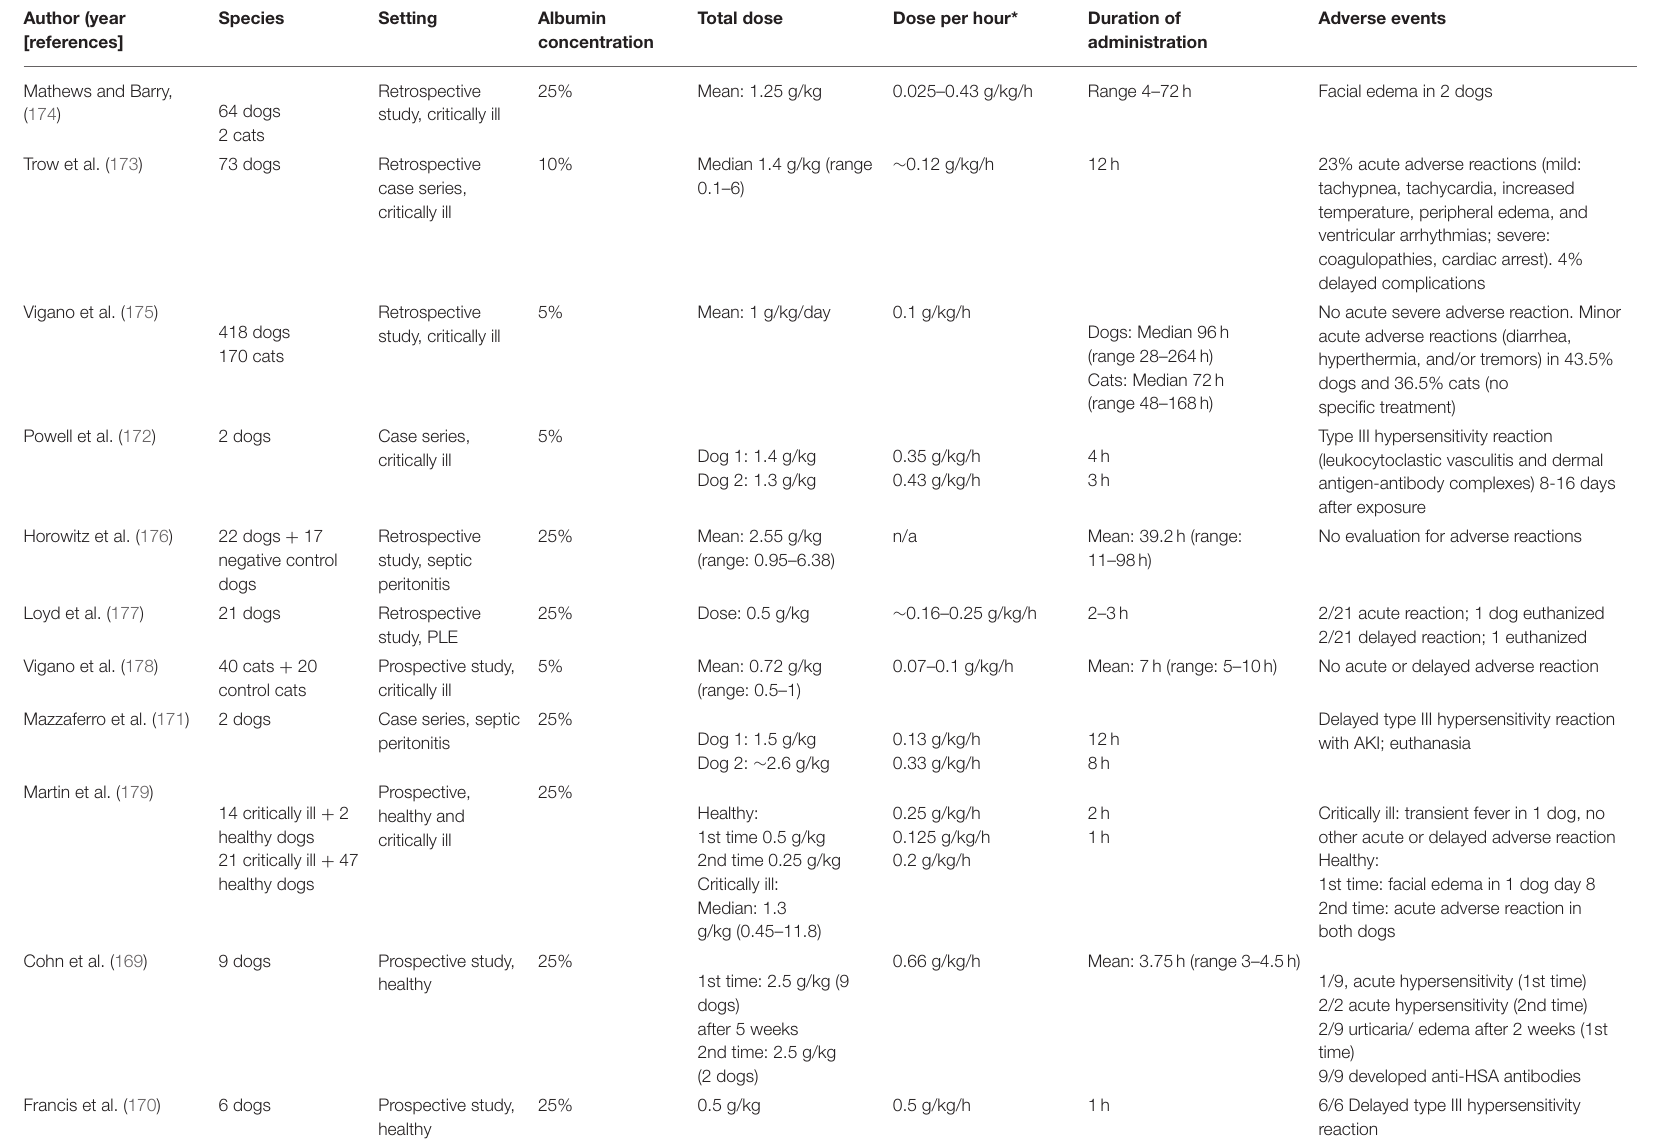
TABLE 3 | List of small animal publications using human serum albumin solutions and its